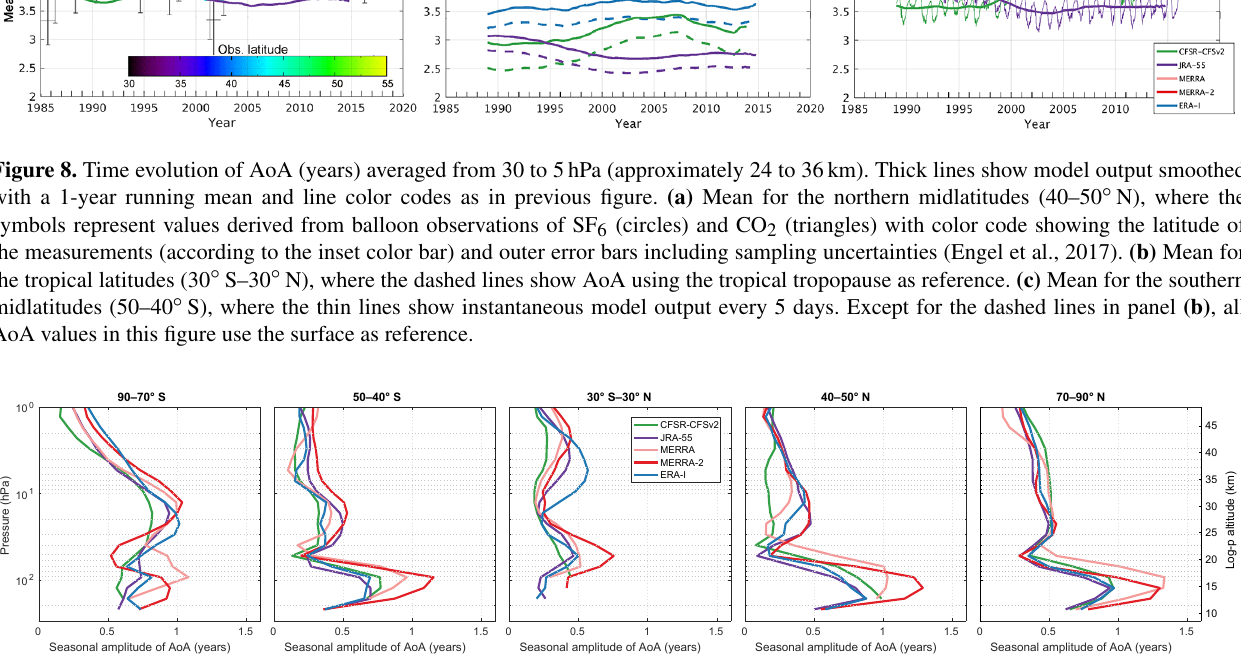
Figure 9. Amplitude (in years) of the seasonal variation in the 2002–2015 linear regression fit of AoA, as a function of pressure and averaged in five latitude bands, from left to right: North Pole (70–90 ◦ N); northern midlatitudes (40–50 ◦ N); tropics (30 ◦ S–30 ◦ N); southern midlatitudes (50–40 ◦ S); South Pole (90–70 ◦ S). The same color codes are used as in previous